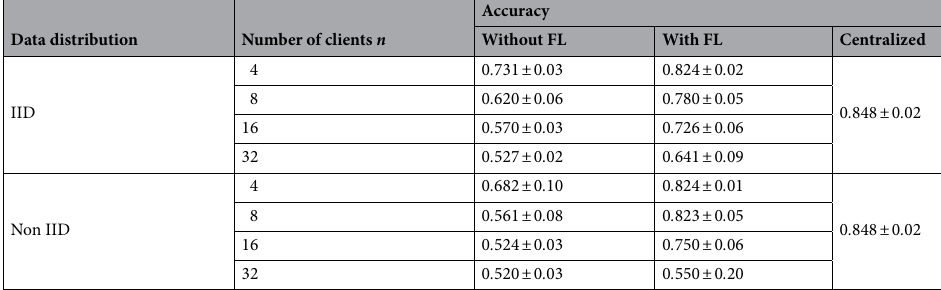
Table 1. Evaluation on different data distributions. Centralized accuracy denotes the accuracy when the data is centralized. The accuracy without FL is the mean and standard deviation of accuracy values across multiple clients without any collaboration. The accuracy with FL is the mean and standard deviation of the central model trained at the end of FL evaluated on each client dataset.